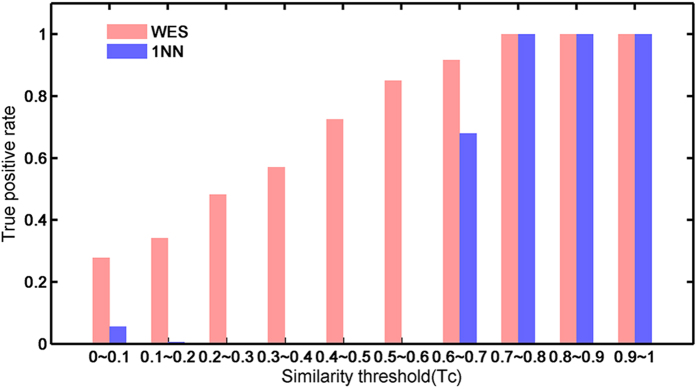
Comparsion of WES with 1NN.The ture positive rate of WES (red) and 1NN (blue) are shown as bars along with the similarity bins (x-axis).